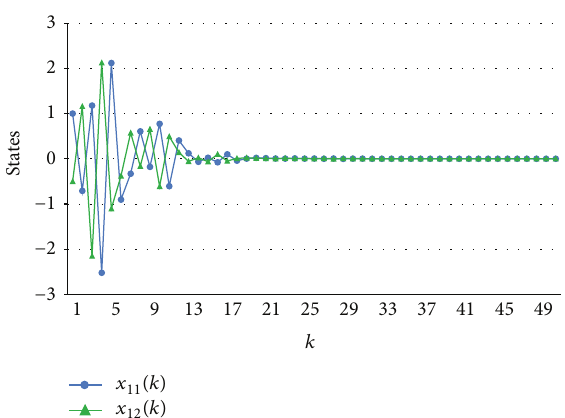
Figure 1: States respond of subsystem 1, 𝑥 11 (𝑘) and 𝑥 12 (𝑘) under discrete-time integral VSC.